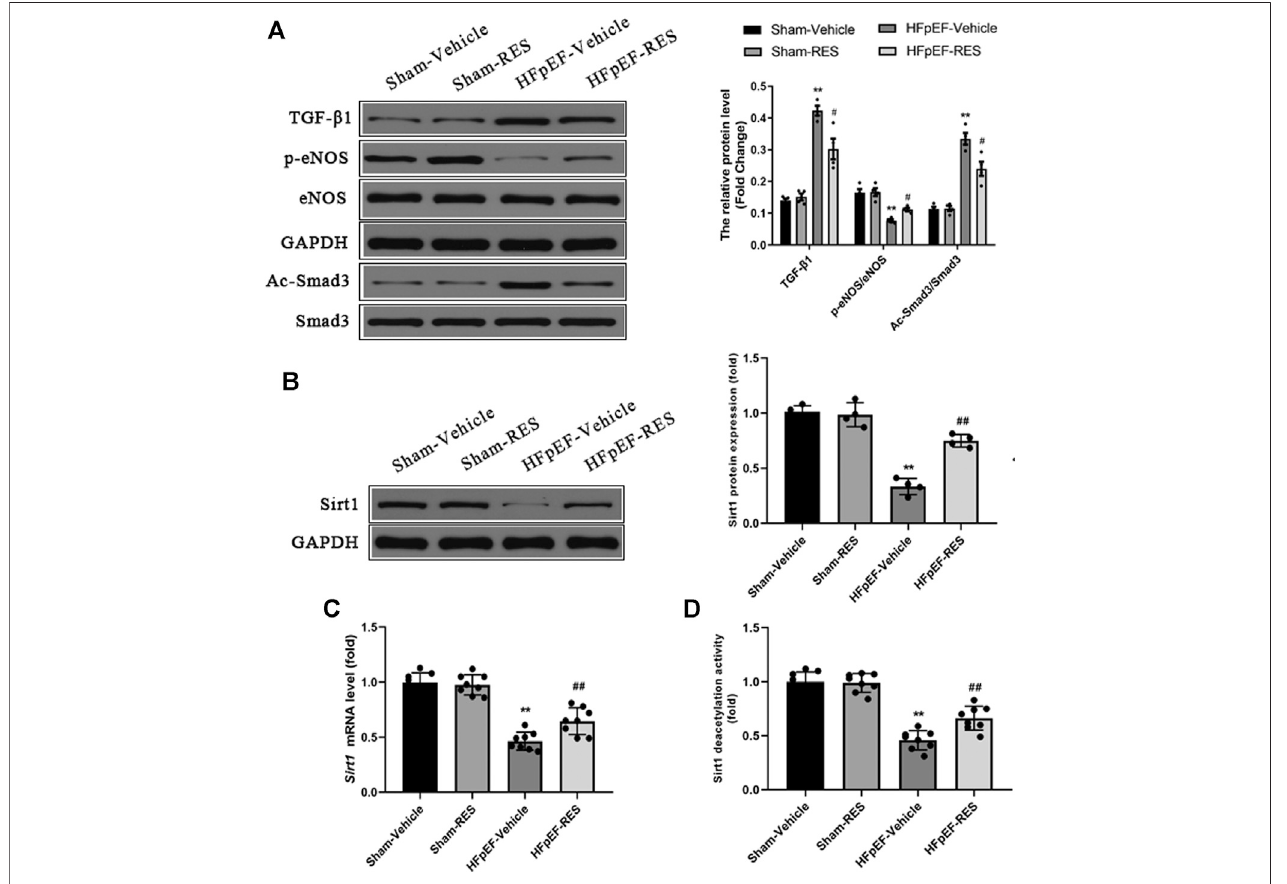
FIGURE 7 | Effect of RES on the HFpEF-activated TGF- β /Smad3 signaling pathway and Sirt1 expression. (A) Representative western blots, immunoprecipitation, and quantitative results of the TGF- β 1, Smad3, Ac-Smad3, p-eNOS, and eNOS proteins ( n (cid:2) 4 per group). (B) Representative western blots and quantitative results of the Sirt1 proteins ( n (cid:2) 4 per group). (C) Quantitative results of Sirt1 mRNA ( n (cid:2) 8 per group). (D) Quantitative results of Sirt1 deacetylation activity ( n (cid:2) 8 per group). ** p < 0.01 vs. sham-vehicle group. # p < 0.05 vs. HFpEF-vehicle group.